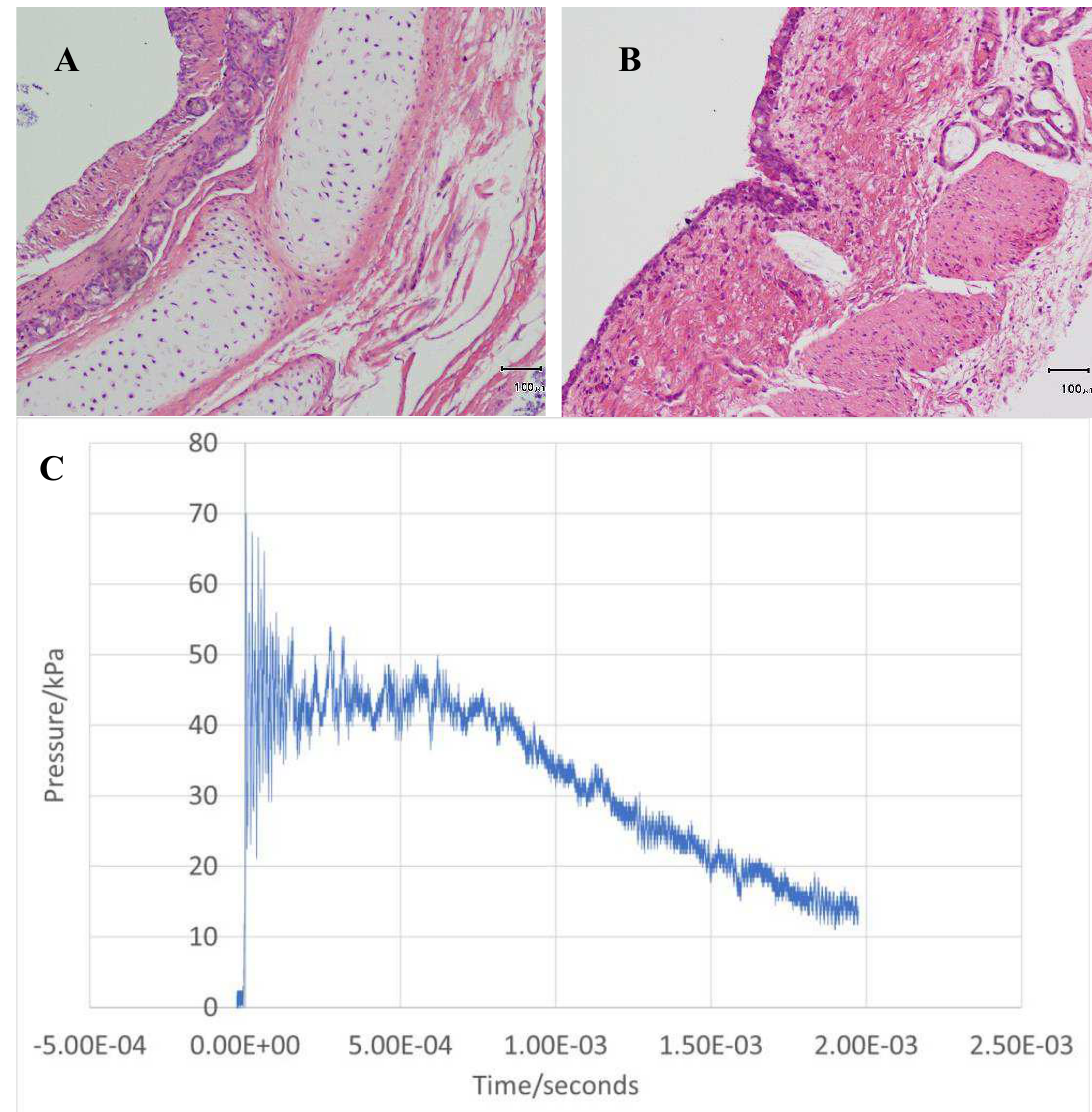
Fig. 2 Comparative histological images of bronchiole EVOC samples together with a corresponding pressure trace. (A) Control sample that has undergone identical processing to test samples without having experience a pressure pulse (sham). (B) Sample was exposed to a pressure pulse with a diaphragm burst pressure of 2.19 bar. At this pressure, some parts of the topmost epithelial layer are sloughed off (evidence of desquamation) compared to the sham sample. (C) Pressure trace, as measured by a piezoelectric sensor, of the experiment on the sample shown in